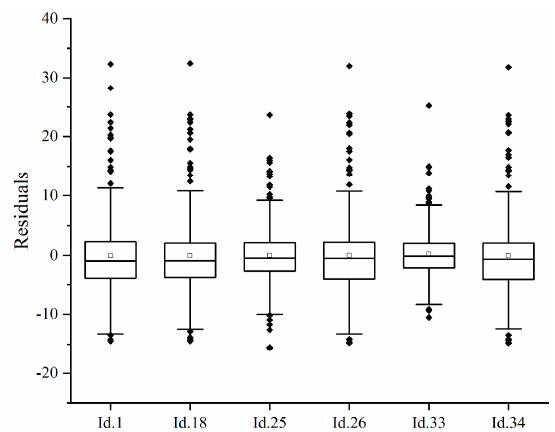
Figure 4. Residual analysis of the trained network of the best BAI models for A. angustifolia in a mixed ombrophilous forest in Southern Brazil.